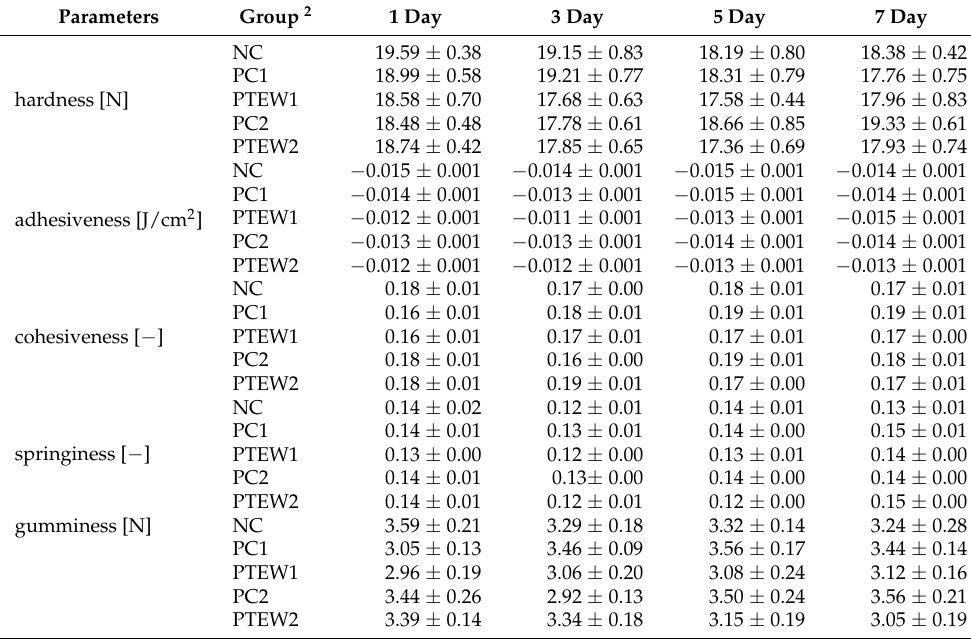
Table 6. The effect of plasma-treated egg whites on color parameters (mean ± SE 1 ) of liver p â t é s during storage.